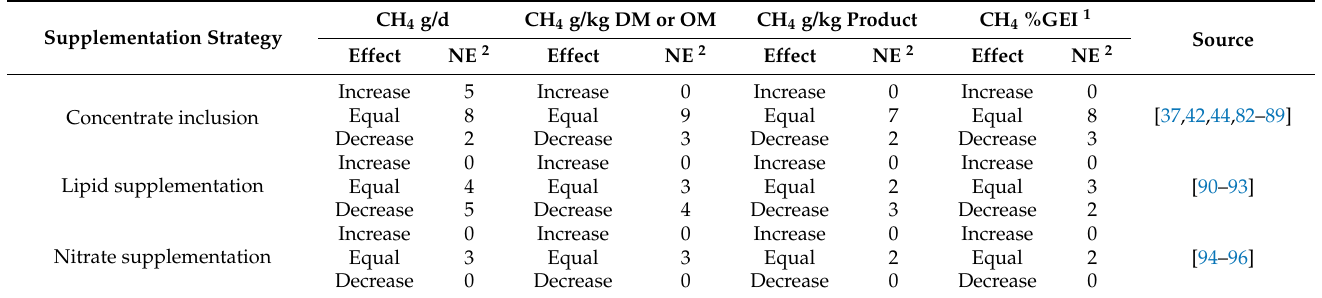
Table 2. Number of experiments that reported either increased, decreased, or not modified CH 4 emissions when supplementing concentrates or nitrates to ruminants under grazing